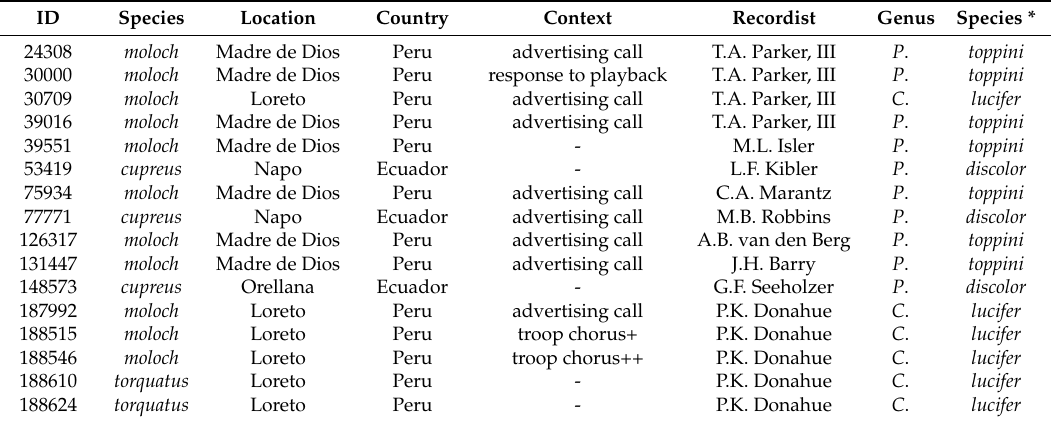
List of the Macaulay Library Catalogue recordings analyzed in the present